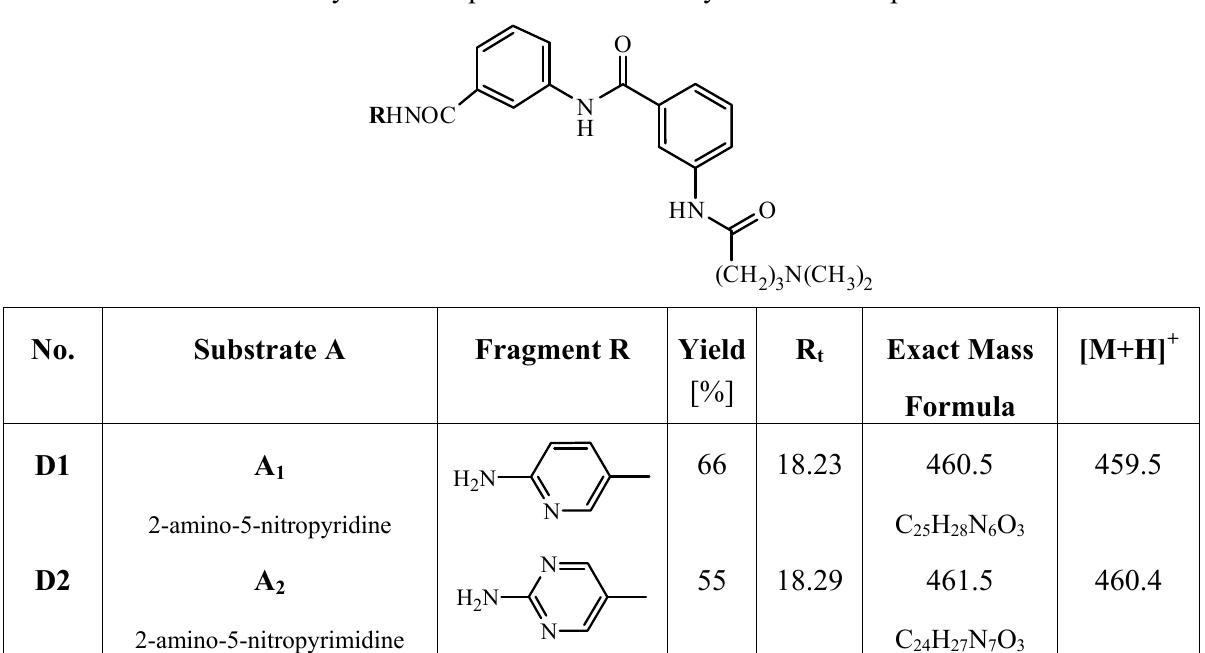
Table 1. Analytical and spectral data of the synthesized compounds D1 - D6